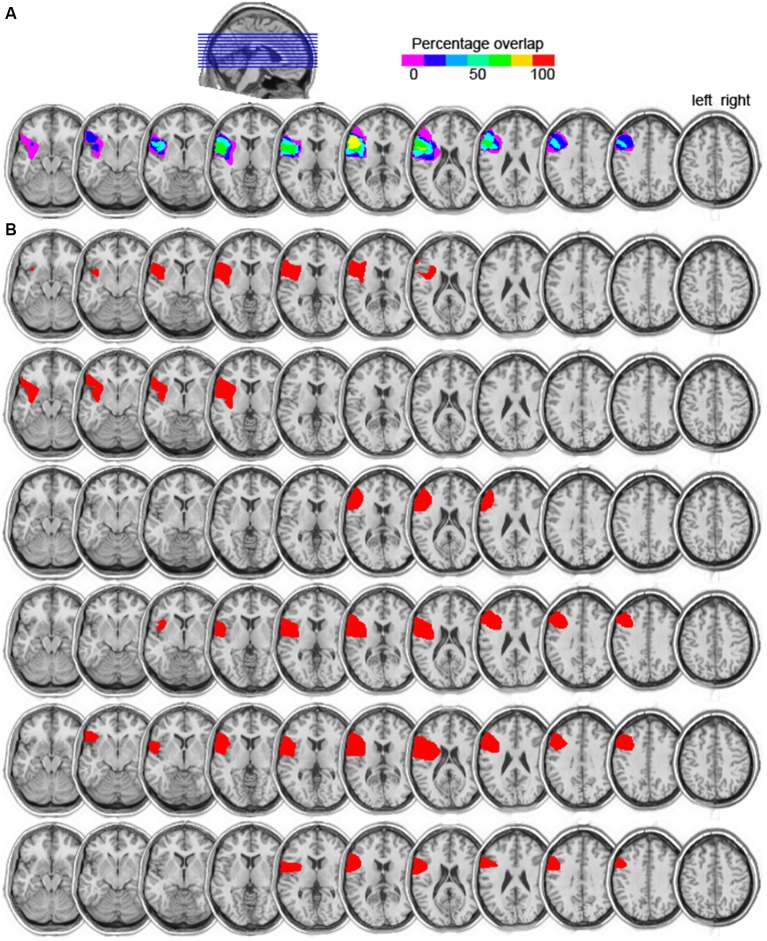
(A) Lesion overlap map of the six left prefrontal cortex (PFC) patients. The color scale indicates the amount of overlap in lesion locations, with magenta indicating that only one patient had a lesion in that particular region (i.e., 0% overlap). The maximum overlap, shown in yellow, indicates that five of the six patients had a lesion in that particular region (slices 6 and 7 from left to right). (B) Individual lesion reconstructions, shown in red. Each patient is shown in a subsequent row, from P1 (top) to P6 (bottom).